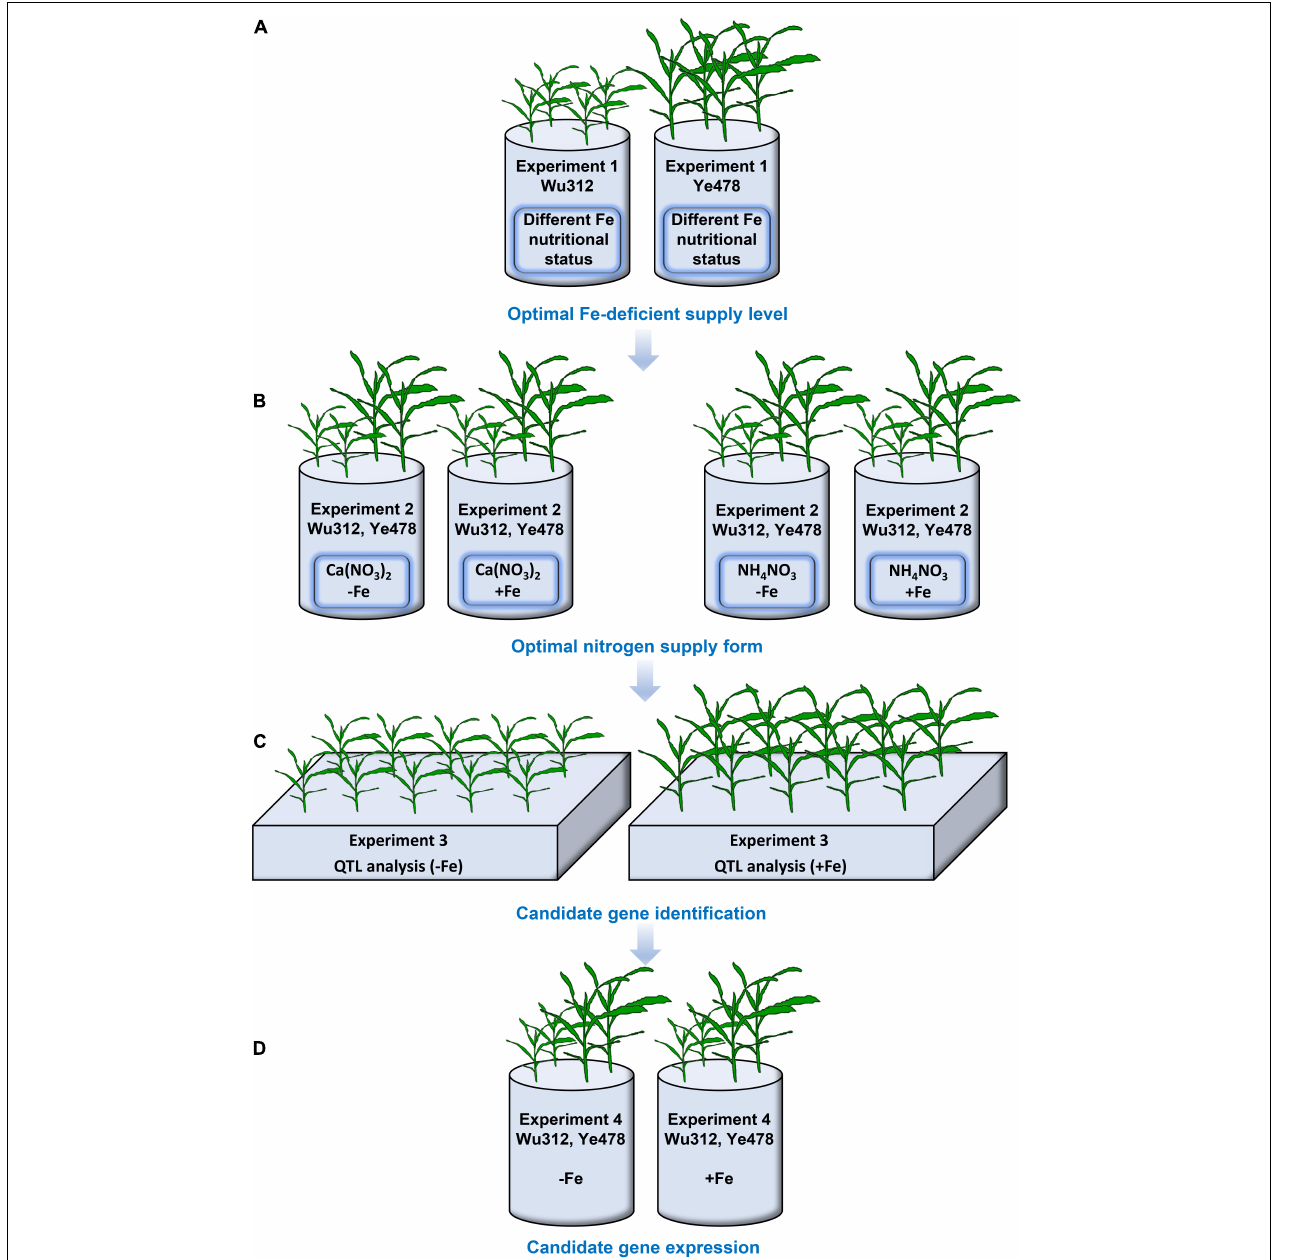
FIGURE 1 | An experimental setup in this study. (A) In Experiment 1, eight different Fe(III)-EDTA levels (0, 10, 30, 50, 70, 100, 200, and 300 µ M) were designed. And four seedlings of inbred lines Wu312 or Ye478 were hydroponically grown in a 3.3-L container as a replicate. Each treatment contained three replicates. (B) In Experiment 2, two seedlings of each inbred line were grown in a 3.3-L container supplied with Ca (NO 3 ) 2 [4 mM NO 3 − -N] or NH 4 NO 3 [2-mM NO 3 − -N and 2-mM NH 4 + -N] under Fe-deficient [–Fe: 30- µ M Fe(III)-EDTA] and Fe-sufficient conditions [+Fe: 200- µ M Fe(III)-EDTA] as a replicate. Each treatment contained three replicates. (C) In Experiment 3, a recombinant inbred line (RIL) population derived from Fe-inefficient inbred line Wu312 and Fe-efficient inbred line Ye478 was grown under the –Fe and +Fe conditions to identify the quantitative trait loci associated with Fe deficiency tolerance. Each treatment contained three replicates. (D) In Experiment 4, the expression of candidate genes identified from Experiment 3 was analyzed in the shoots and roots of Wu312 and Ye478 under the –Fe and +Fe conditions. Each treatment contained three